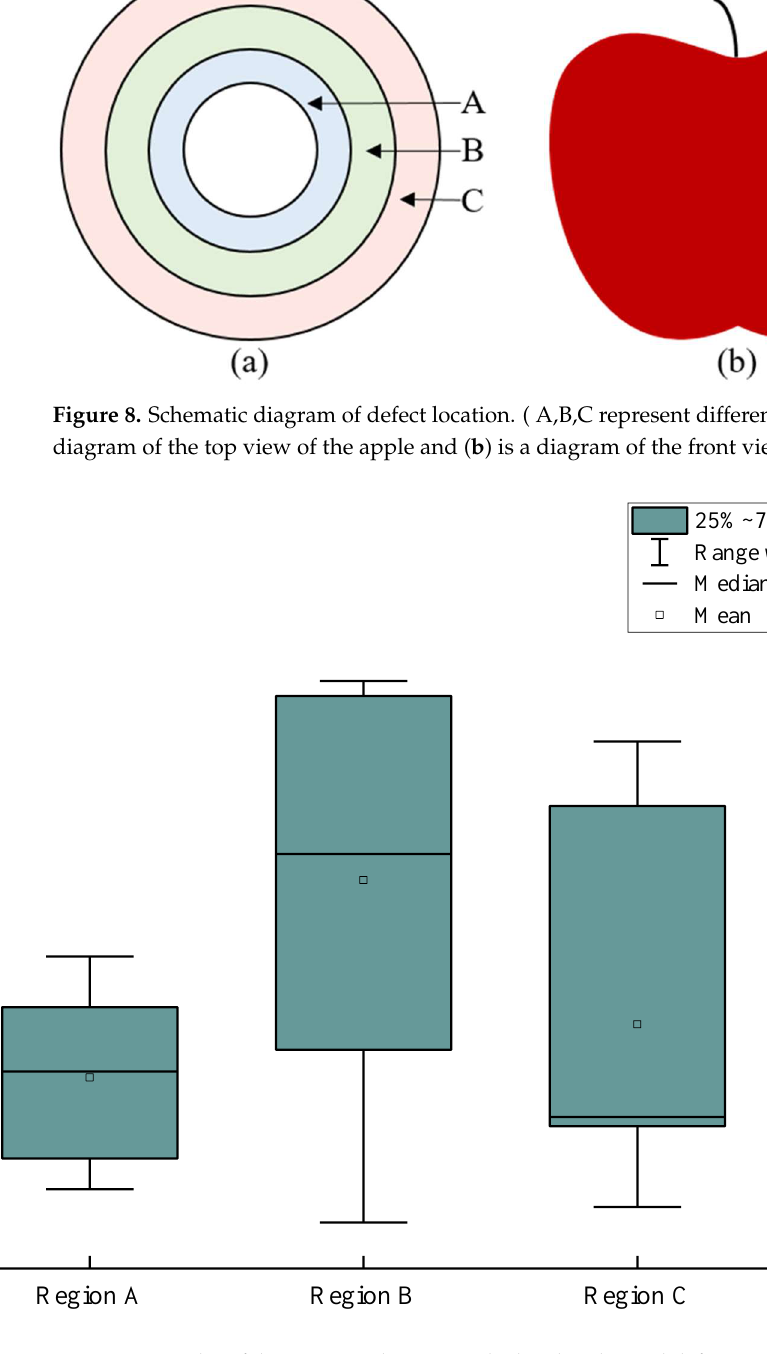
Figure 9. Boxplot of the error rate between calculated and actual defect area at different regions of fruit. Table 3. Calculation results of defect area.